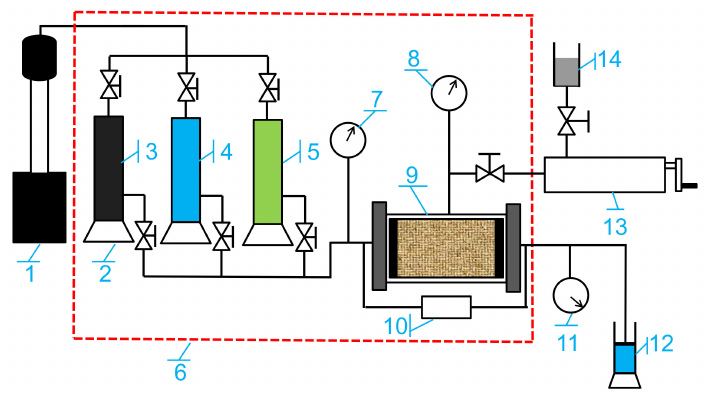
Figure 1. Schematic diagram of the core displacement tests. (1) Flooding pump; (2) flooding fluid vessel; (3) crude oil in the vessel; (4) waterflooding fluid in the vessel; (5) microbial flooding fluid in the vessel; (6) constant-temperature oven; (7) flooding pressure gauge; (8) peripheral pressure gauge; (9) core holder; (10) pressure transducer; (11) exit pressure gauge; (12) measuring cylinder; (13) manual metering pump; (14) hydrating